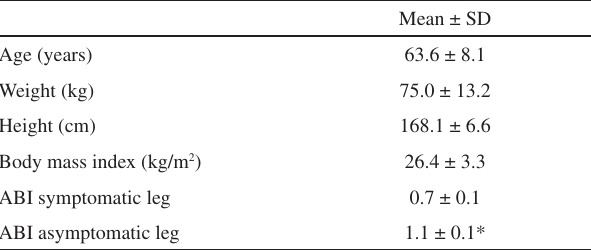
Table 1 - Clinical characteristics of samples (n = 11)